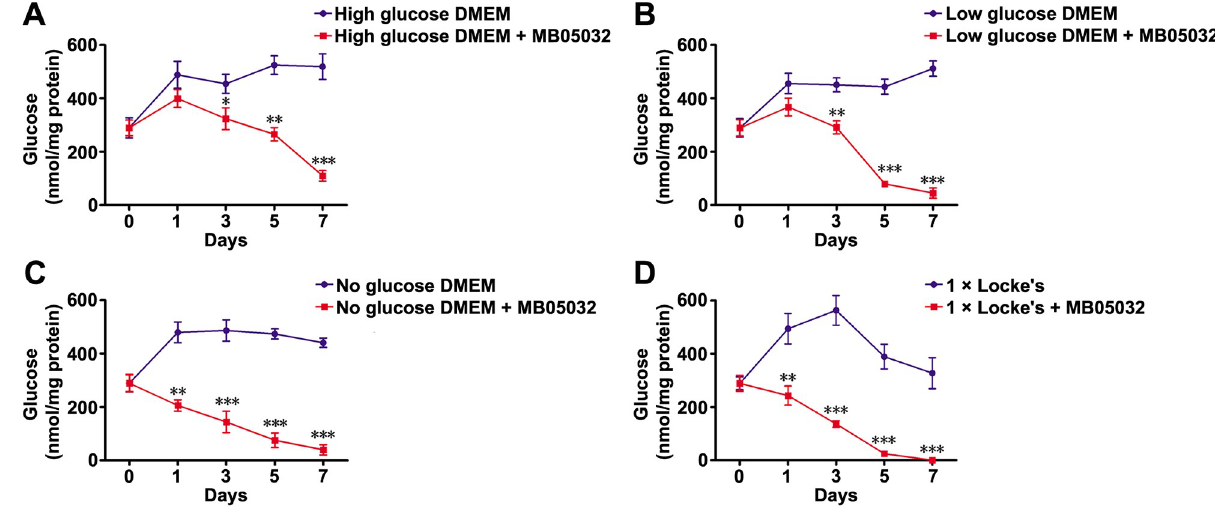
Fig 6. Glucose level inside C . sinensis adults with or without MB05032 treatment. Adult flukes were respectively maintained on high, low, and no glucose DMEM (A, B, and C), as well as 1 × Locke’s (D) with or without the addition of MB05032. Glucose level was detected at 0, 1, 3, 5, and 7 d of feeding. Differences between two groups were evaluated by student’s t test. � P < 0.05, �� P < 0.01, and ��� P < 0.001 were represented as statistical significance.